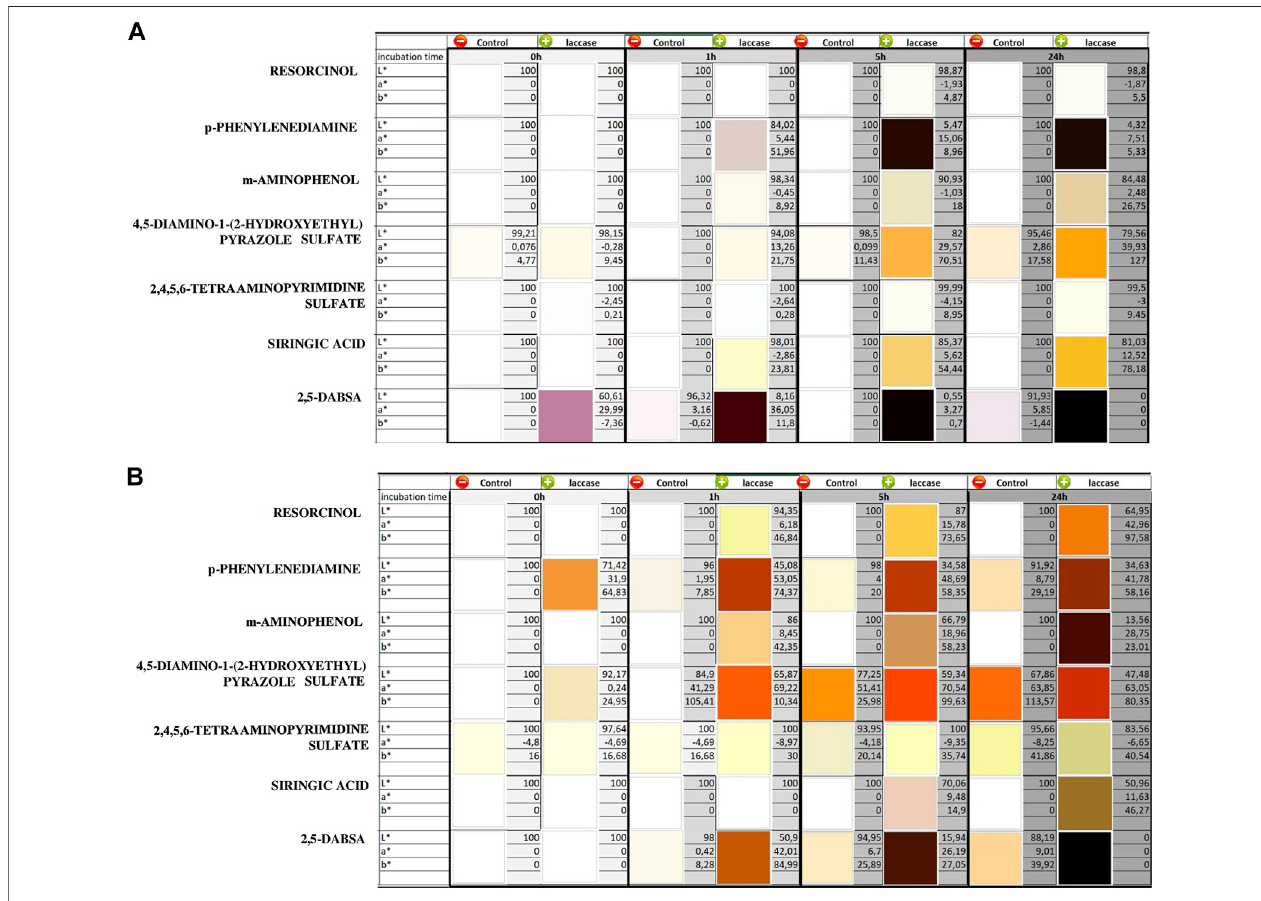
FIGURE 2 | CIELAB color values and related color images of the reacted solutions containing one monomer at different times at pH 3 (A) and pH 9 (B) . The solutions were evaluated at different time of laccase incubation (0, 1, 5, and 24 h). The controls were analyzed under the same conditions by means of heat-inactivated laccase. The standard deviations were less than 3 units of Δ E for each color value